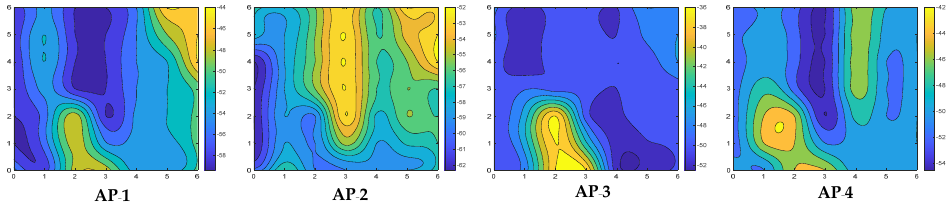
Figure 2. Spatial distribution of Wi-Fi signal strength.